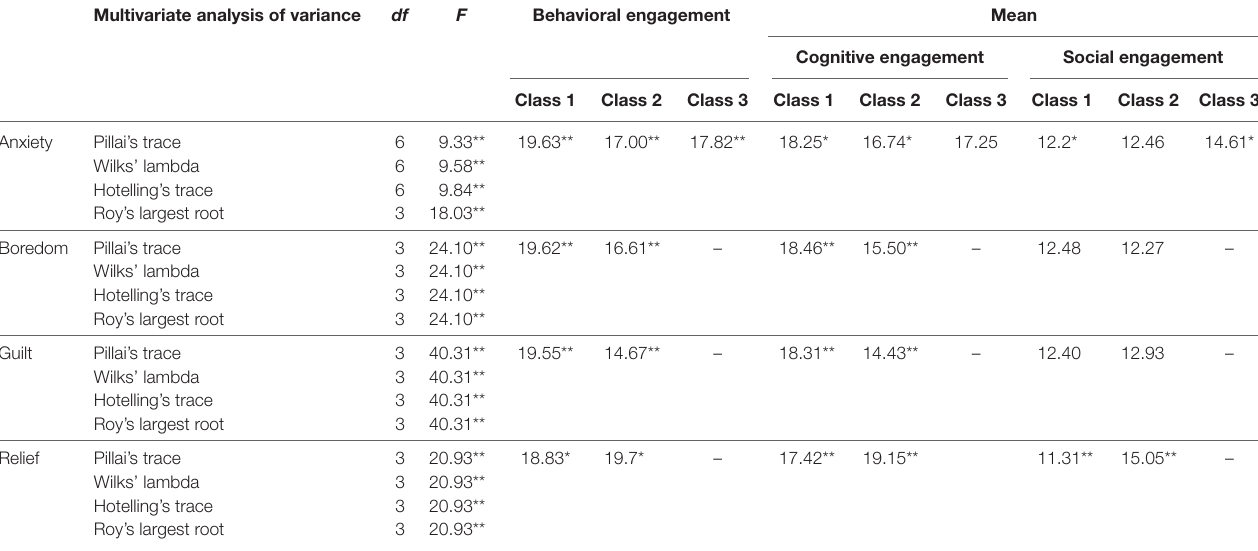
Table 5 | Differences in engagement among emotion profiles. Multivariate analysis of variance df F